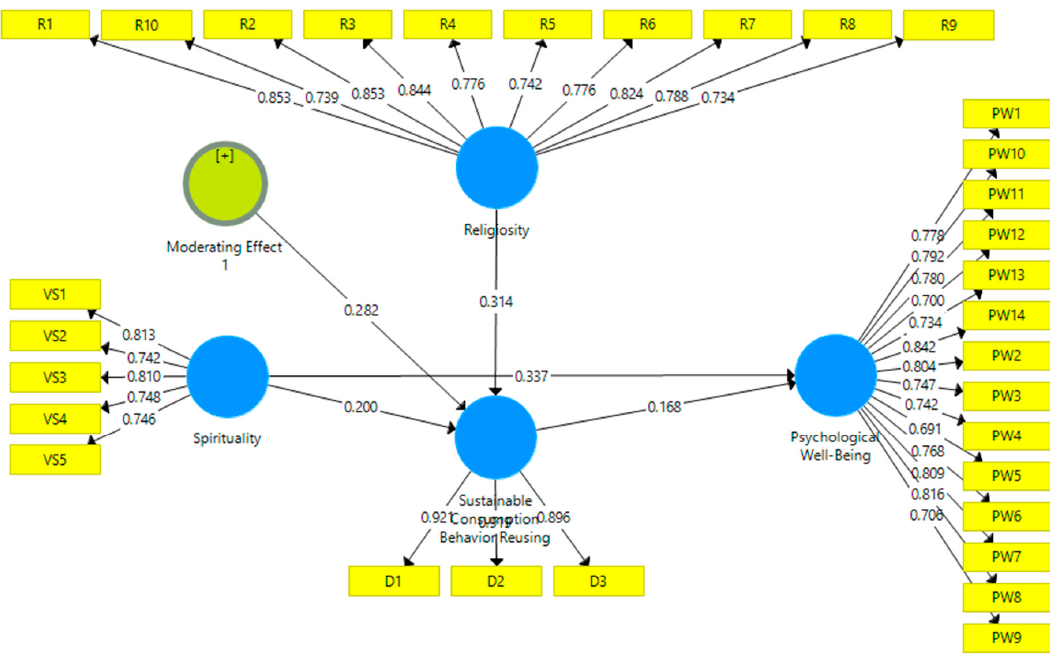
Figure 3. SmarPLS output. Table 5. Path coe ffi cients for indirect relationships.